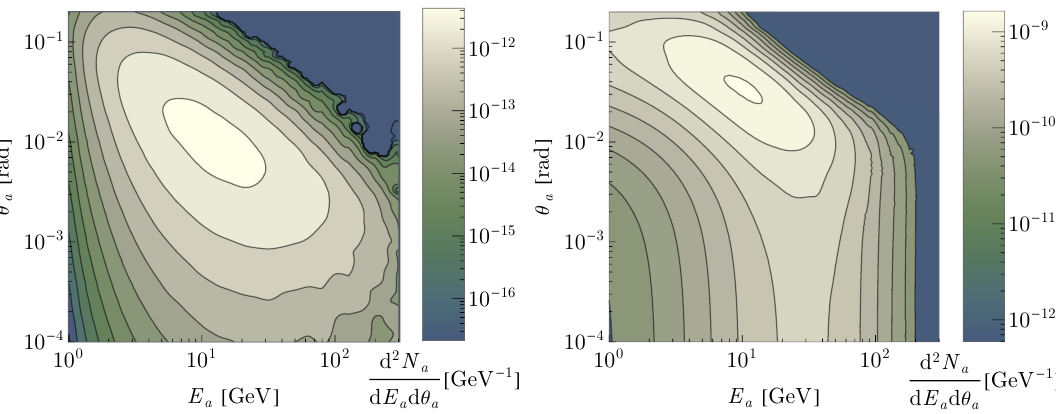
Figure 1 . Production differential yields for an m a = 0 . 5 GeV ALP produced at a copper target with a 400 GeV proton beam. For a photon-from-meson induced production (left) with a fixed C γγ / Λ = 10 − 4 GeV − 1 and for an a - η mixing (right) assuming a fixed mixing angle θ aη = 10 − 4